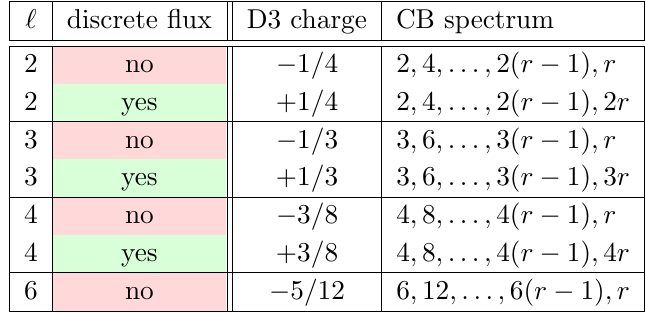
Table 1. Basic properties of N =3 S-folds. Note that the D3-charge (cid:15) is given by the uniform formulas (cid:15) (cid:13)uxless = (cid:0) ‘ (cid:0) 1 , (cid:15) (cid:13)uxful = + ‘ (cid:0) 1 . 2 ‘ 2 ‘